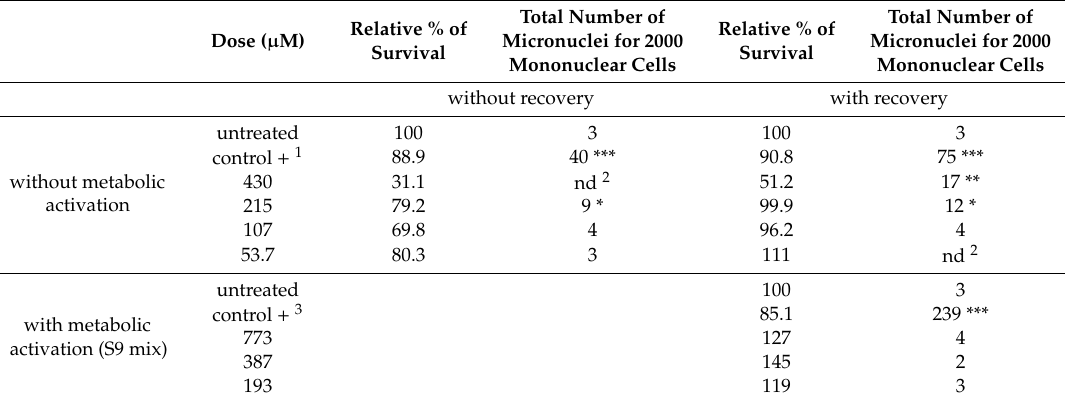
Table 2. Results of the micronucleus assay on L5178Y mouse lymphoma